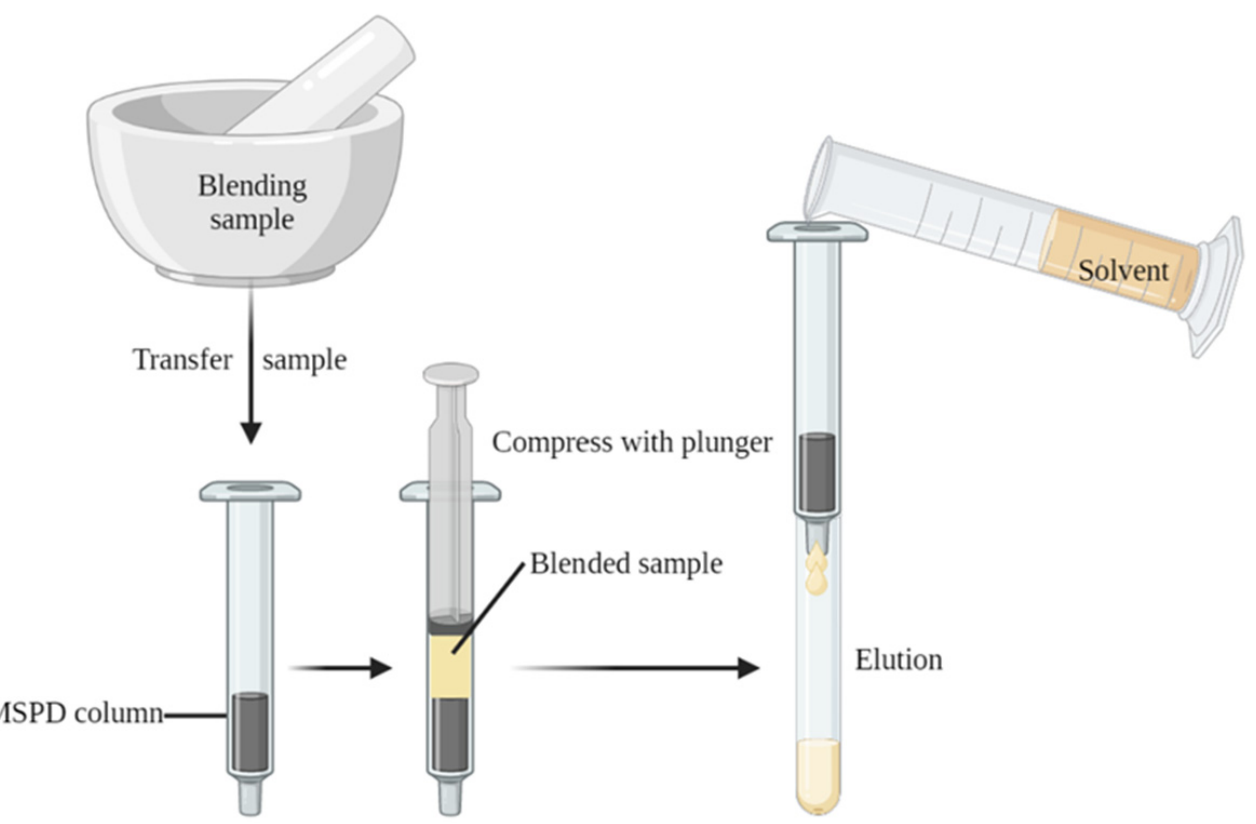
Figure 4. Schematic diagram of a typical MSPD extraction process.